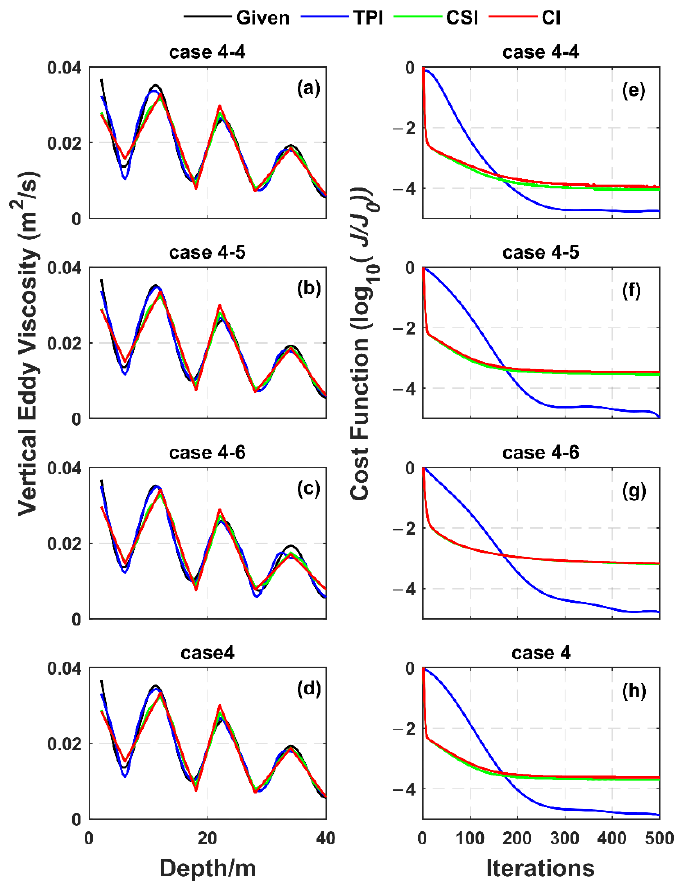
Figure 5. On the left are the prescribed and inversion distributions of the VEVCs after using different BLDs. Panels ( a – d ) correspond to Cases 4-4, 4-5, 4-6, and 4, respectively. On the right are the cost functions of the three schemes in Group 3. Panels ( e – h ) correspond to Cases 4-4, 4-5, 4-6, and 4, respectively.